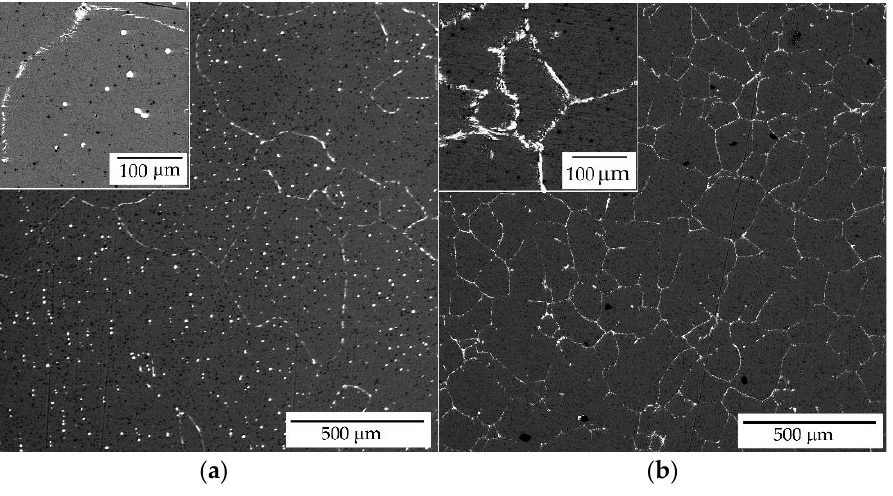
Figure 1. EBSD images of the structure of grains ( a ) AlYb AC, ( b ) AlMnYbZr AC, ( c ) AlYb CR40, ( d ) AlMnYbZr CR70.